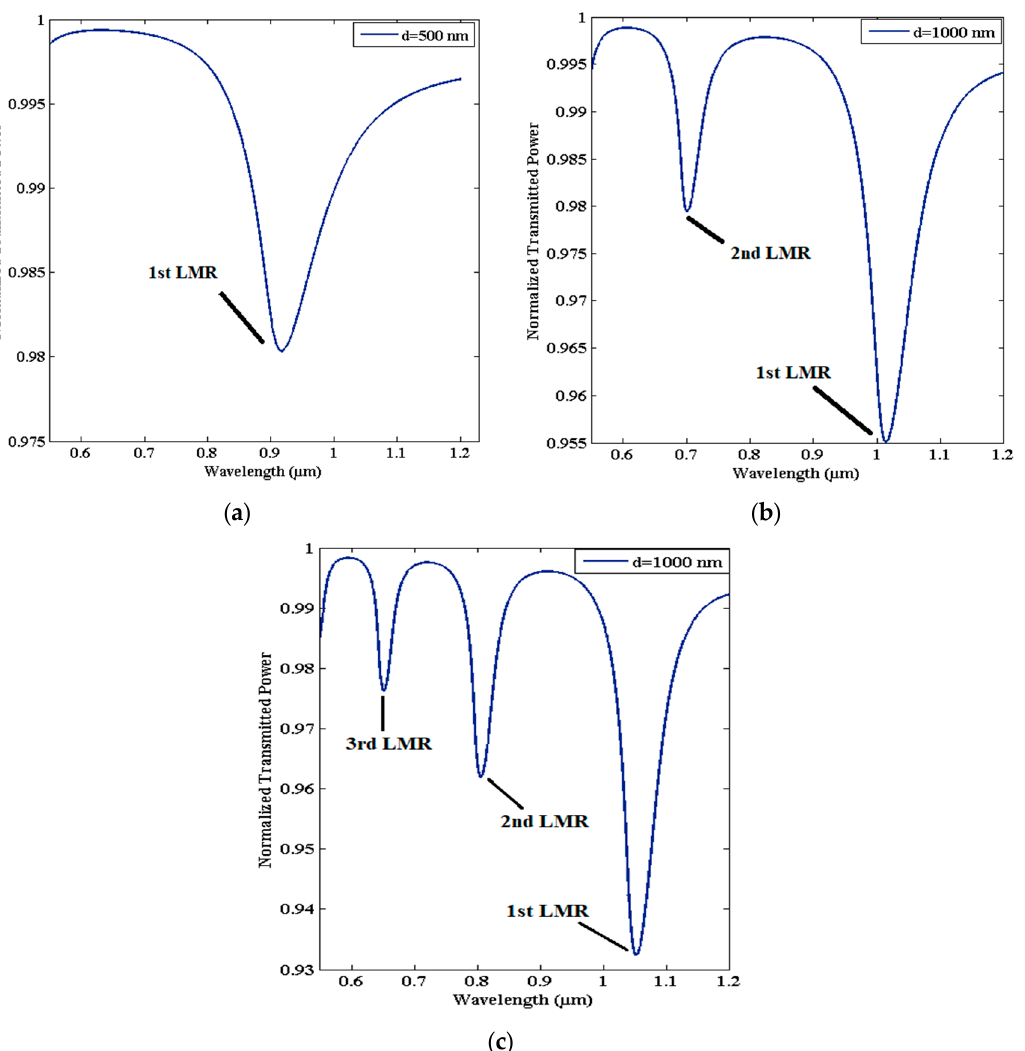
Figure 1. Transmission spectra of LMR-based FOS coated with AZO, having thicknesses of ( a ) 500 nm, ( b ) 1000 nm, and ( c ) 1500 nm. Other parameters that were used: SMRI = 1.333, length of sensing region = 0.5 cm, numerical aperture = 0.22, and core diameter = 600 µm.